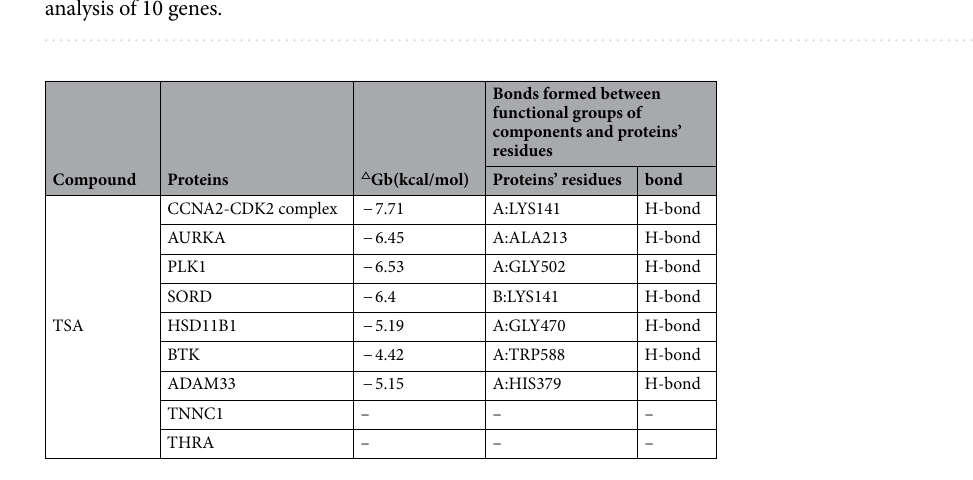
Table 1. Dock binding free energies( △ Gb) and bonds of the